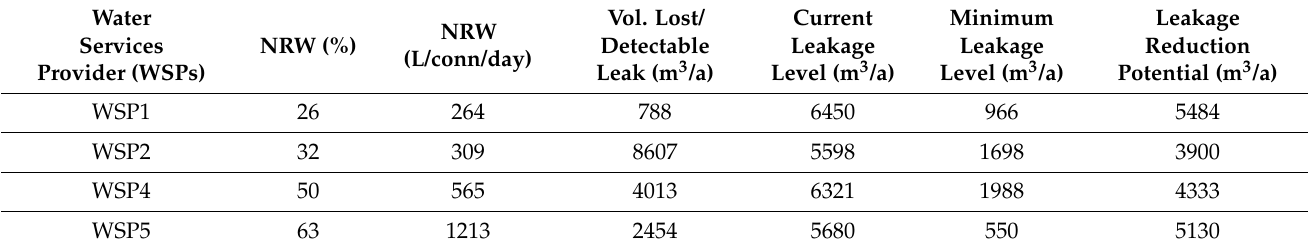
Table 6. Non-revenue water, leakage and leakage reduction potential for the WSPs in 2019. Data for WSP3 is not shown.